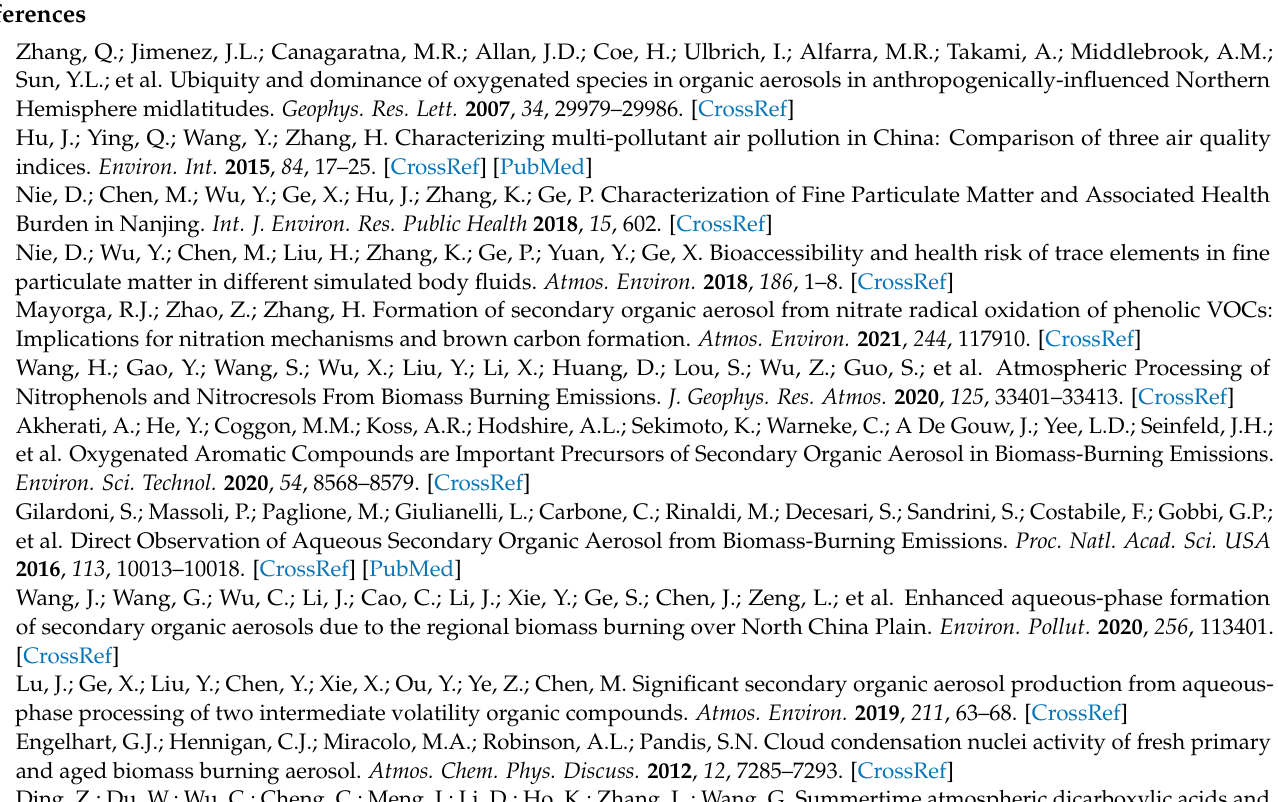
Figure S3. Mass spectra of (a) HQ + OH and (b) HQ+3,4-DMB at different reaction times. The H/C, O/C ratios and OSc values are also shown. The colored sticks represent 6 ion families: C x H y , C x H y O 1 , C x H y O 2 , H y O 1 , C x H y O 3 and C x H y O 4 . The ion signals at m/z > 100 are amplified 30 times for clarity, Figure S4. Evolution profiles of aqueous-phase SOA: (a) f 44 (mass ratio of ion signal at m/z 44 to total organic signal) vs. f 43 (mass ratio of ion signal at m/z 43 to total organic signal). (b) Van Krevelen (VK) diagram based on AMS data, in which lines with slopes of 0, − 1 and − 2 represent the reaction pathways with additions of alcohol/peroxide, carboxylic acid, and ketone/aldehyde functional group, respectively. Dashed lines are OSc values, Figure S5. Three-factor solution for PMF analysis of OH-mediated oxidations of